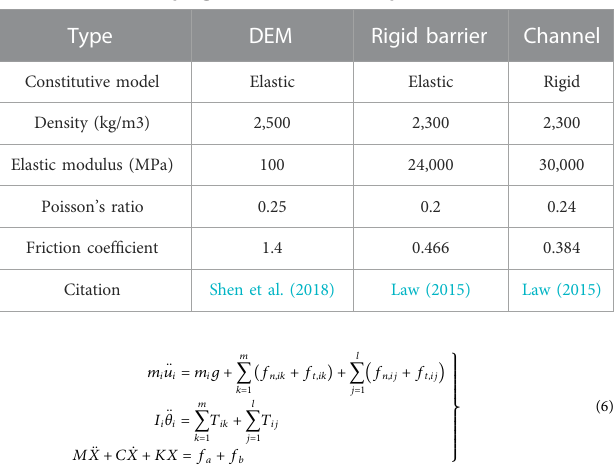
TABLE 1 DEM-FEM coupling numerical simulation